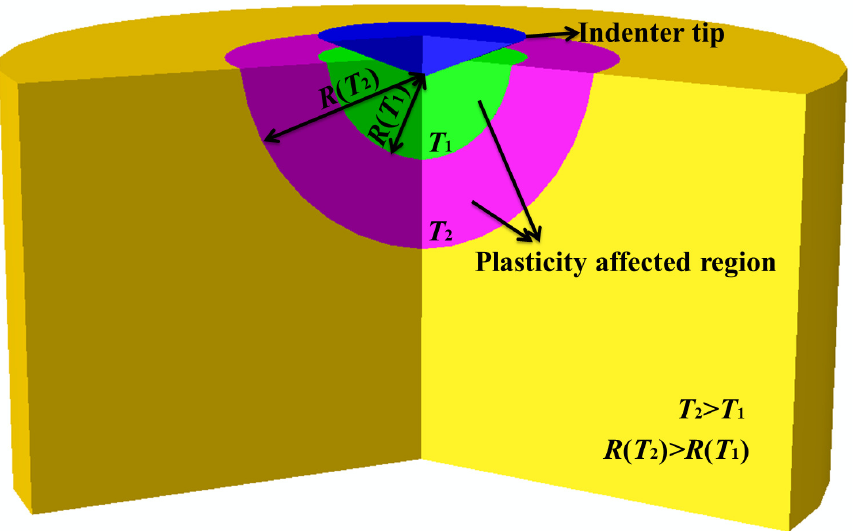
Figure 1. (Color online) Schematic of the nano-indentation of single crystal materials at two different temperatures, that is, T 2 > T 1 . The plasticity affected region is assumed as a hemisphere with radius of R , and R ( T 2 ) > R ( T 1 )